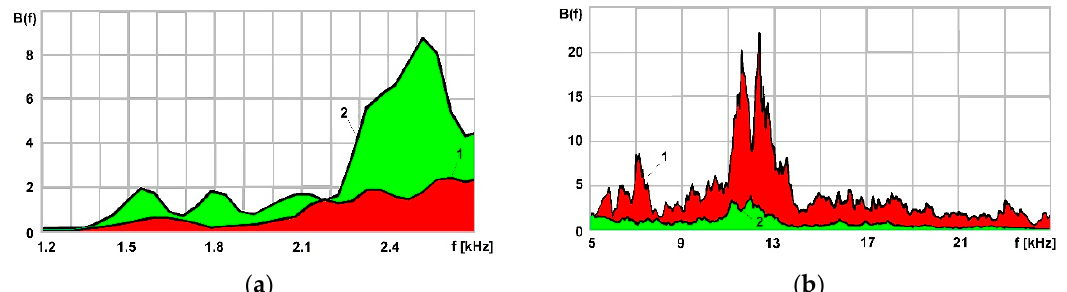
Figure 8. The record of FRF during electrical discharge machining of M05 hard alloy: ( a ) is in the low-frequency range; ( b ) is in the high-frequency range; (1) is at the moment of wire approach; (2) is before the wire break.